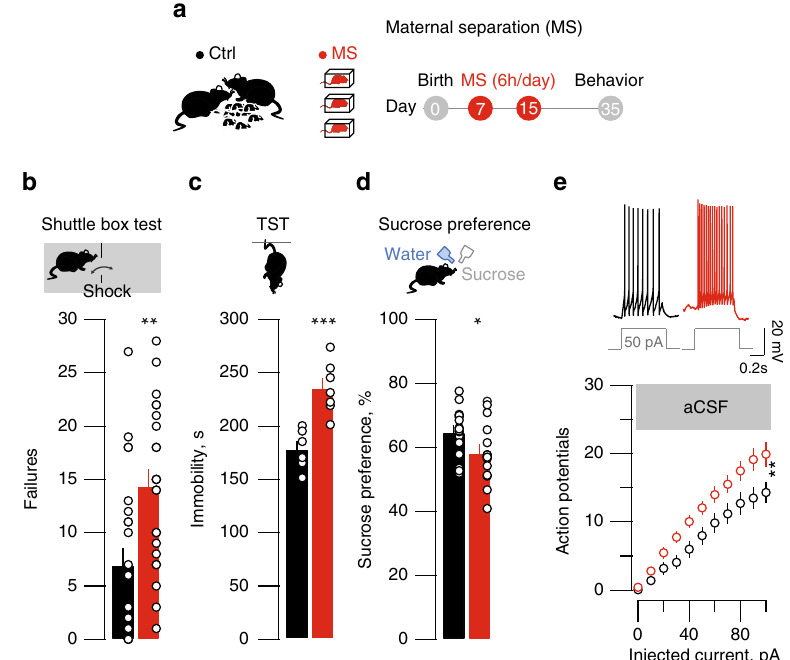
Fig. 1 MS-induced depressive-like symptoms and hyperexcitability. a MS protocol (all schematics are original drawing made by authors). b Bar graph and scatter plot of failures in the shuttle box for control (Ctrl) and MS mice (Ctrl vs. MS; n mice = 24, unpaired t -test, t 45 = 3.36 ** p < 0.01). c Same as b for TST immobility (Ctrl vs. MS; n mice = 6 – 7; unpaired t -test, t 11 = 4.63; *** p < 0.001). d Same as b but for sucrose preference (Ctrl vs. MS; n mice = 16; unpaired t- test, t 30 = 32.12; * p < 0.05). e Top, sample traces from Ctrl and MS mice of current-evoked fi ring (50 pA step). Bottom, action potentials vs. injected current (0 – 100 pA, steps of 10 pA) in all experimental groups (Ctrl vs. MS; aCSF, nmice = 6 per group; ncells = 23 per group; two-way ANOVA-RM, interaction, F (10;440) = 2.74; ** p < 0.01). Scale bars = 0.2 s and 20